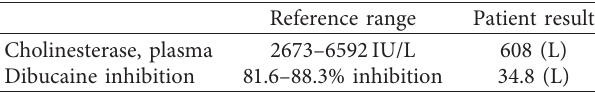
Table 1: Results of the patient’s serum cholinesterase level and the percent inhibition by